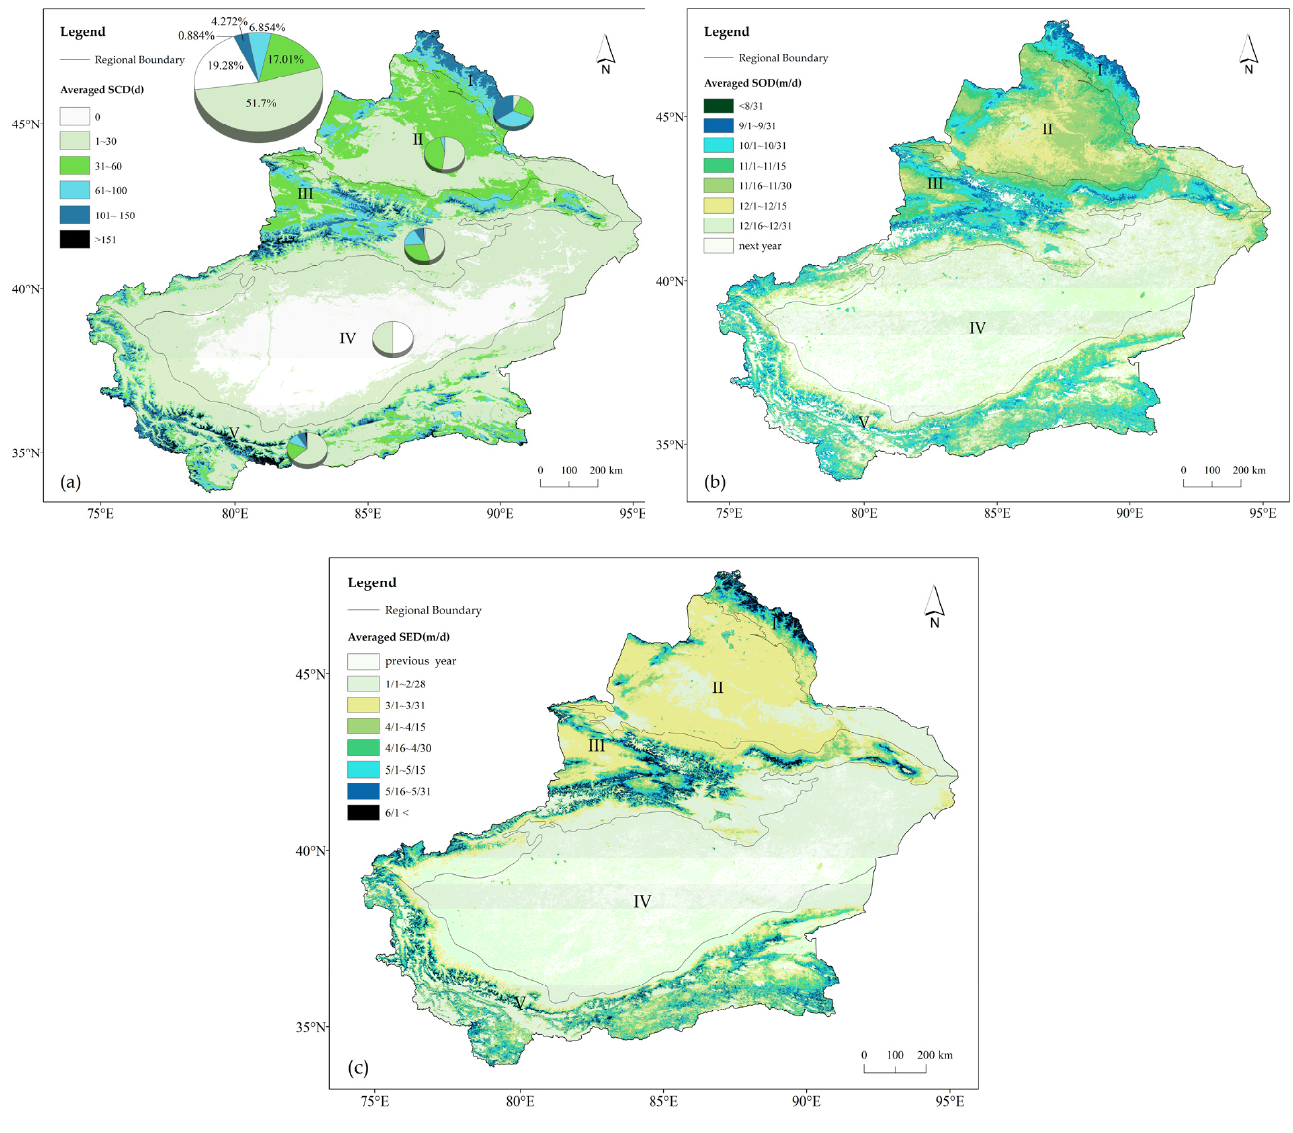
Figure 5. Average snow cover phenology in Xinjiang during 2001–2020: SCD ( a ); SOD ( b ); and SED ( c ).